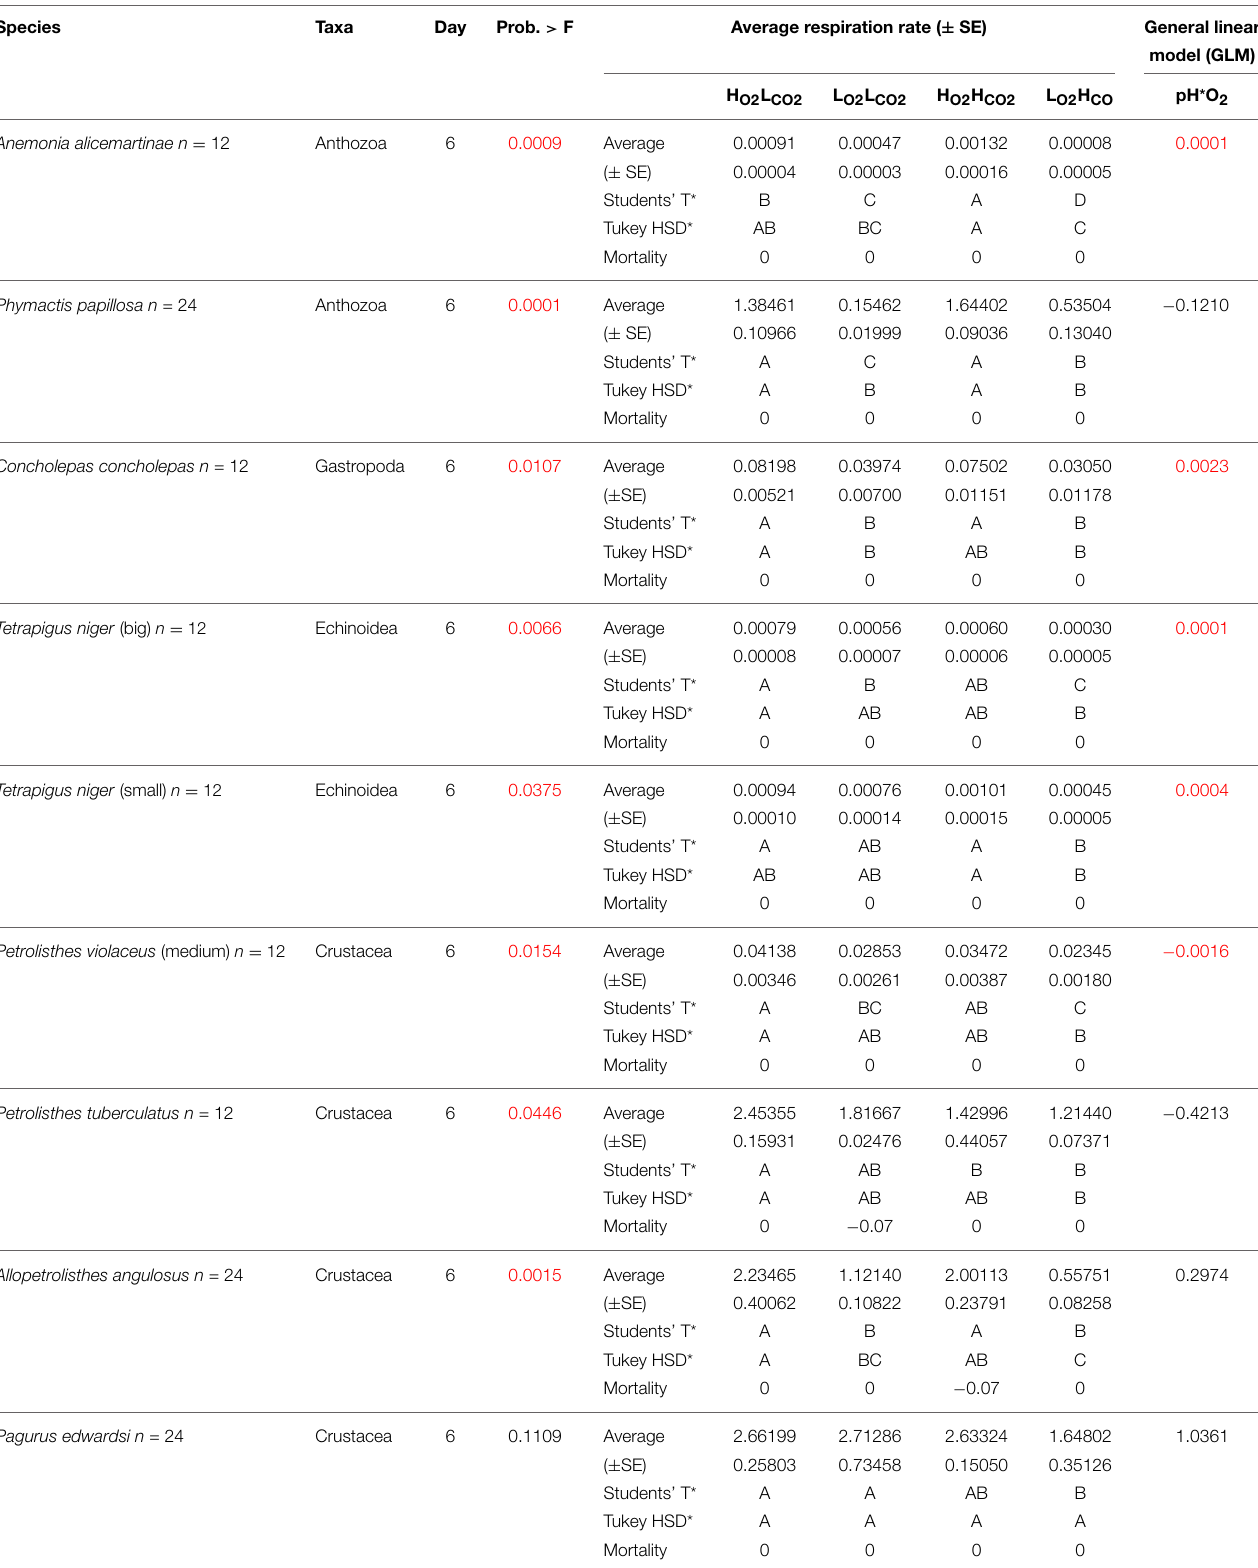
TABLE 2 | Respiration rate ( ± SE) and results of the General Linear Model off all tested species after 6